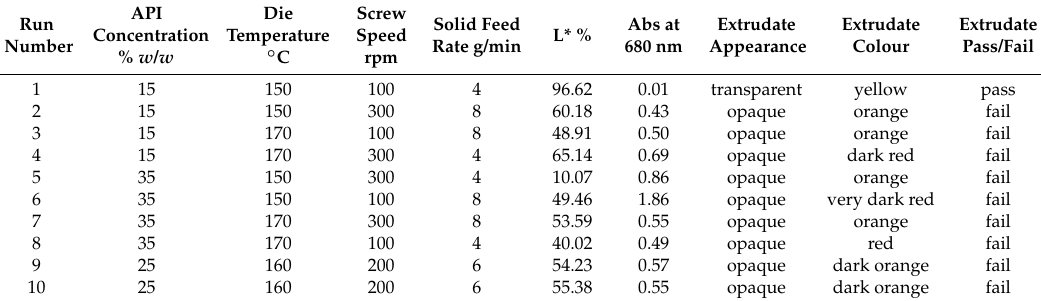
Table 1. DoE1 Screening study with appearance pass/fail outcome.